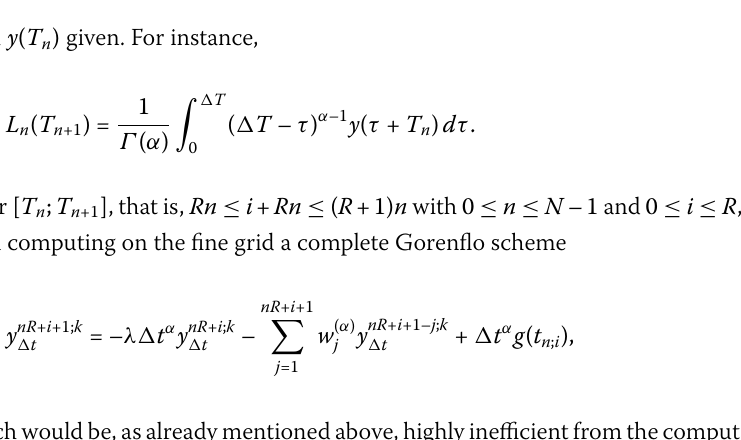
with y ( T n ) given. For